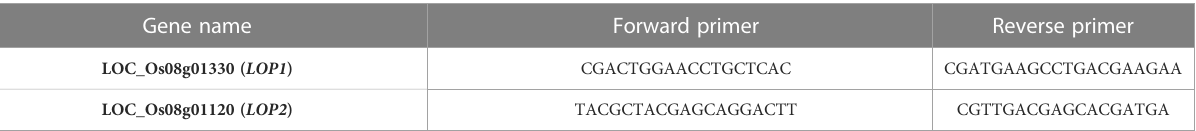
TABLE 1 List of primers used for